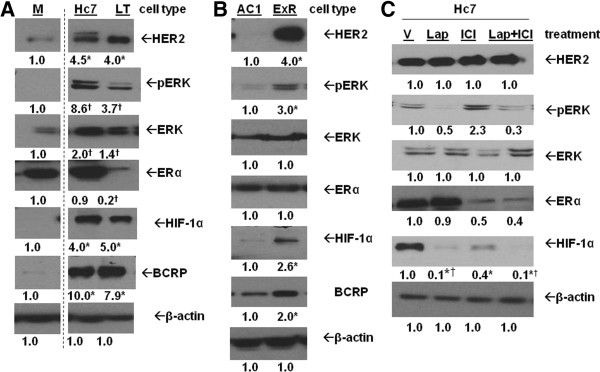
Protein expression in HER2+ cells and exemestane-resistant cells. A) MCF-7Ca (M), Hc7 and LTLTCa (LT) cells were plated in their respective passage media. Total protein was extracted and HER2, phosphorylated- and total-ERK, ERα, HIF-1α, BCRP and β-actin protein were analyzed by Western blot. Shown are representative blots and overall densitometry results of n = 6 independent cell samples/group. Densitometry results are expressed as mean fold-change compared to MCF-7Ca after normalization to ERK (mean ± SD of n = 6 independent cell samples/group; *versus MCF-7Ca, P <0.05; † versus MCF-7Ca, P <0.001, one-way ANOVA). Dashed lines indicate omitted lane in between M and Hc7 of the same blots. B) AC1 (AC1) and AC1-ExR (ExR) cells were plated in their respective passage media. Total protein was extracted and HER2, phosphorylated- and total-ERK, ERα, HIF-1α and β-actin protein were analyzed by Western blot. Shown are representative blots and overall densitometry results of n = 6 independent cell samples/group. Densitometry results are expressed as mean fold-change compared to vehicle-treated cells after normalization to β-actin (mean ± SD of n = 6 independent cell samples/group; *versus vehicle, P <0.0001, two-sided t-test). C) MCF-7/HER2 cells were treated with either vehicle (V), 1 μM lapatinib (Lap), 100 nM ICI 182,780 (ICI) or 1 μM lapatinib + 100 nM ICI 182,780 (Lap + ICI) for 24 hours. Total protein was extracted and HER2, phospho- and total-ERK1/2, ERα, HIF-1α and β-actin were analyzed by Western blot. Shown are representative blots and overall densitometry results of n = 6 independent cell samples/group. Densitometry results are expressed as mean fold-change compared to vehicle-treated cells after normalization to β-actin (mean ± SD of n = 6 independent cell samples/group; *versus vehicle, P <0.0001, one-way ANOVA). ANOVA, analysis of variance; BCRP, breast cancer resistant protein; ERα, estrogen receptor alpha; HER2, human epidermal growth factor receptor 2; HIF-1α, hypoxia inducible factor 1 α subunit; n, number; SD, standard deviation.